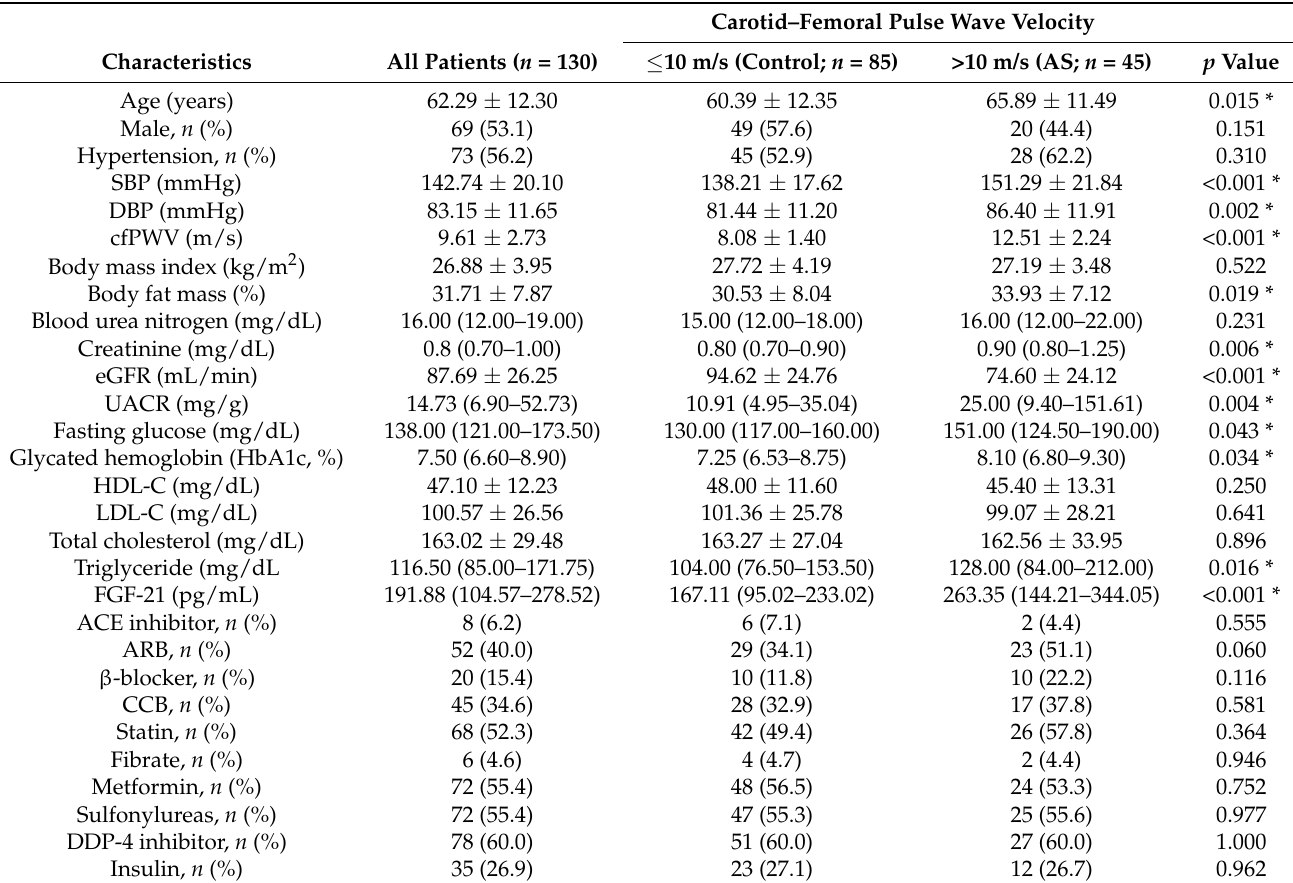
Table 1. Clinical variables of the 130 diabetic patients with or without aortic stiffness.